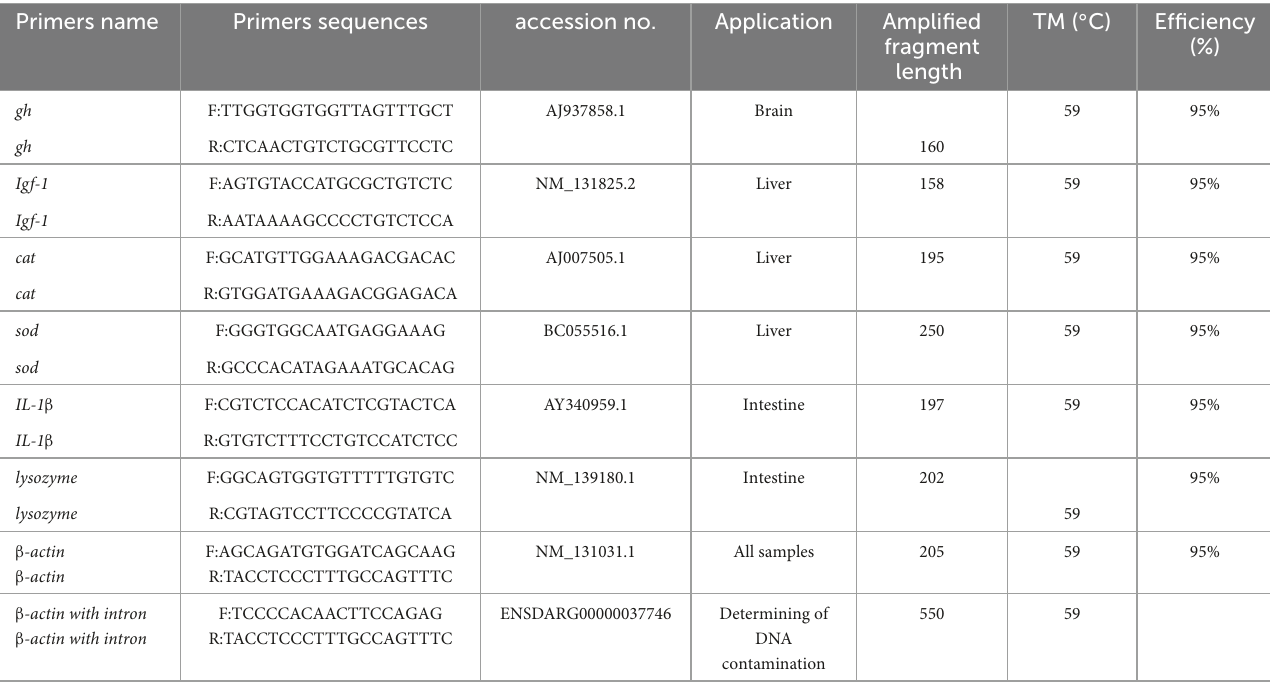
TABLE 3 Primers sequences (F, forward; R, reverse) used for real-time PCR of zebrafish ( Danio rerio ). Primers name